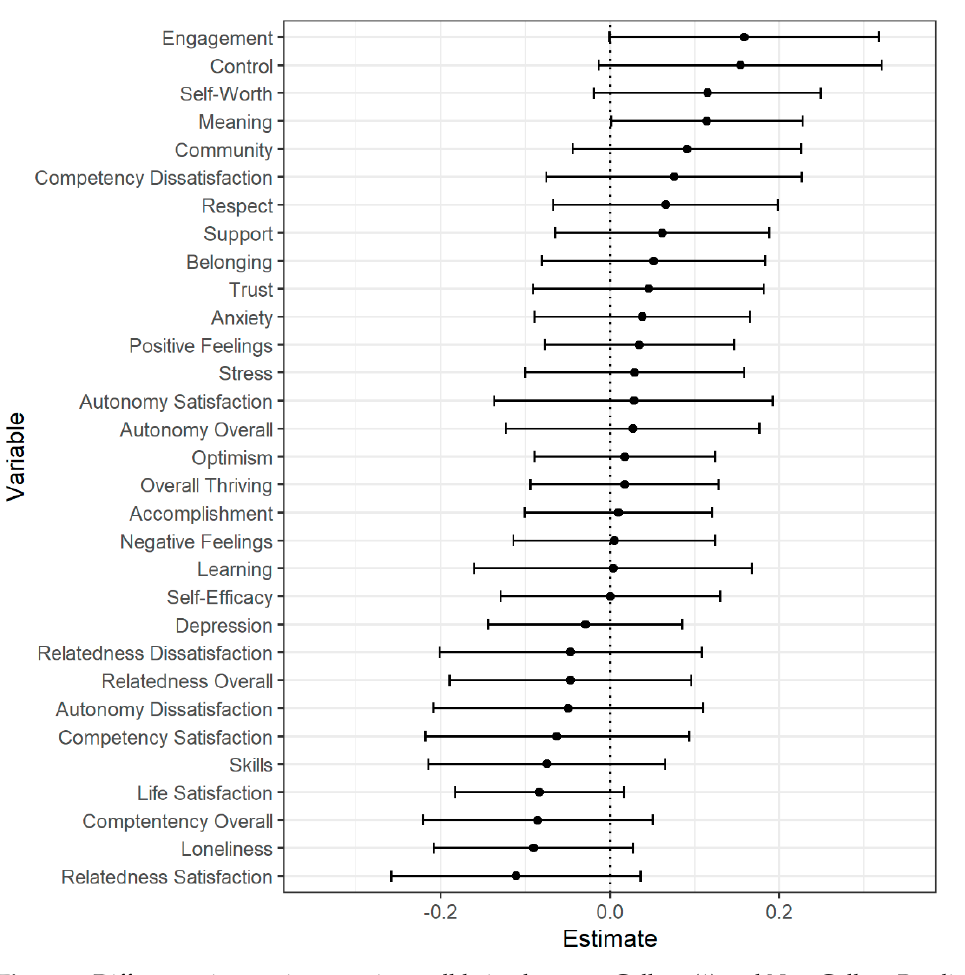
Figure 2. Differences in post-intervention well-being between Gallery (1) and Non-Gallery Reading (0) conditions. Note. Estimates represent regression weights (controlling for pre-intervention well-being) in pre-intervention standard deviation units. Values to the right of zero indicated higher well-being in the Gallery conditions. Error bars represent 95% confidence intervals.